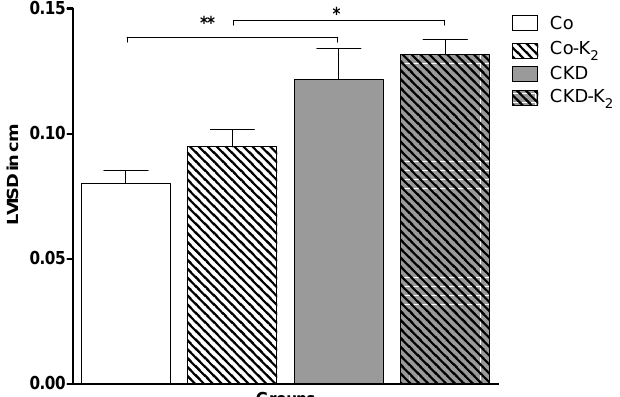
Figure 9. Systolic and diastolic blood pressure. Systolic and diastolic blood pressure after 12 weeks of treatment. CKD animals developed significantly increased systolic and diastolic blood pressure values compared to controls. Co = control group; Co-K 2 = MK-7 supplemented control group; CKD = 5/6 nephrectomized group; CKD-K 2 = MK-7 supplemented 5/6 nephrectomized group; mmHg = millimeters of mercury. Significant differences: * p < 0.05, ** p < 0.01.